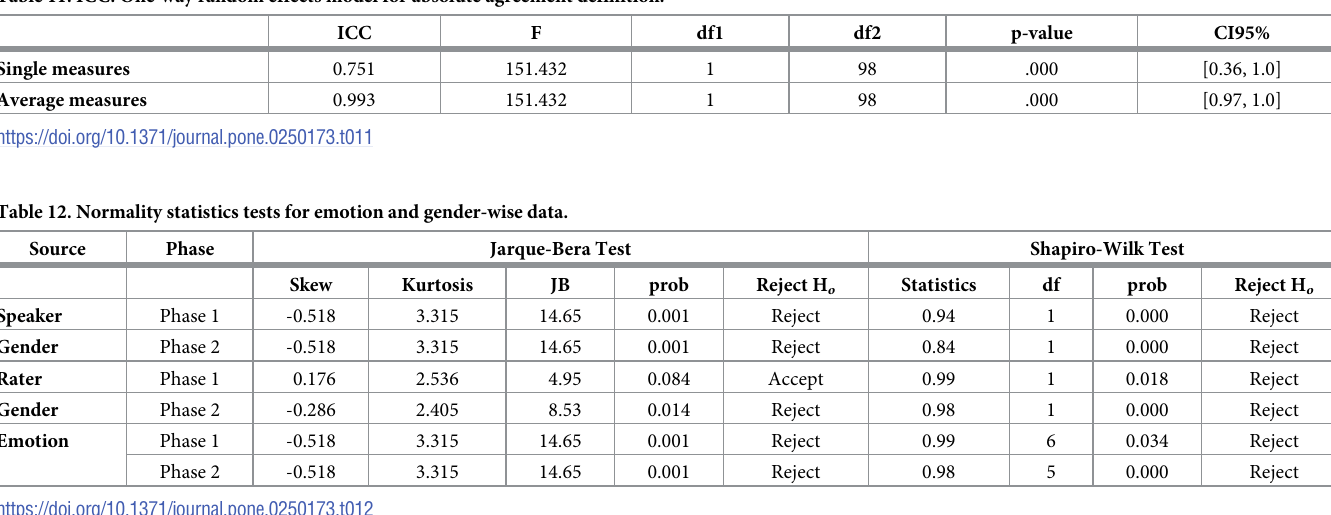
Table 11. ICC: One-way random effects model for absolute agreement definition.